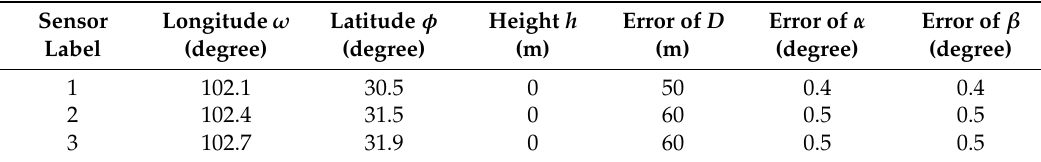
Table 2. System information of the three sensors.